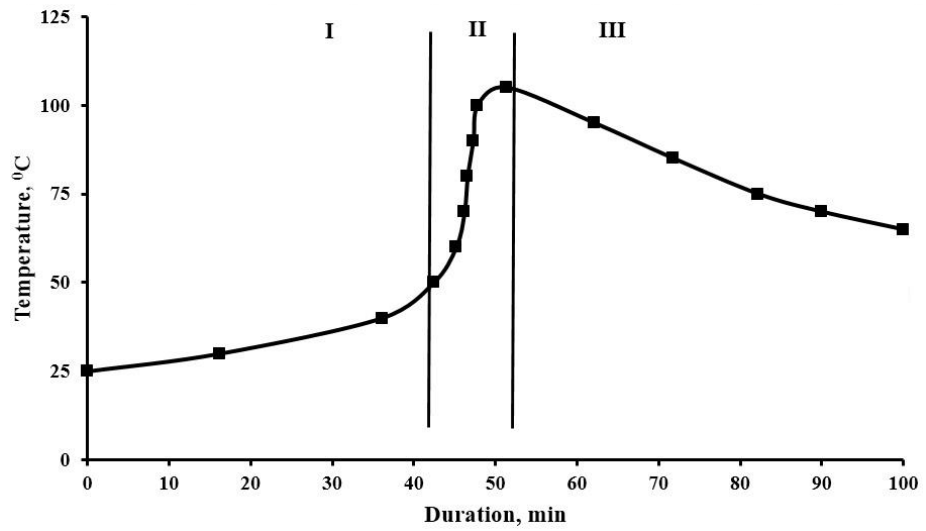
Figure 2. Kinetics of the epoxy composition curing.